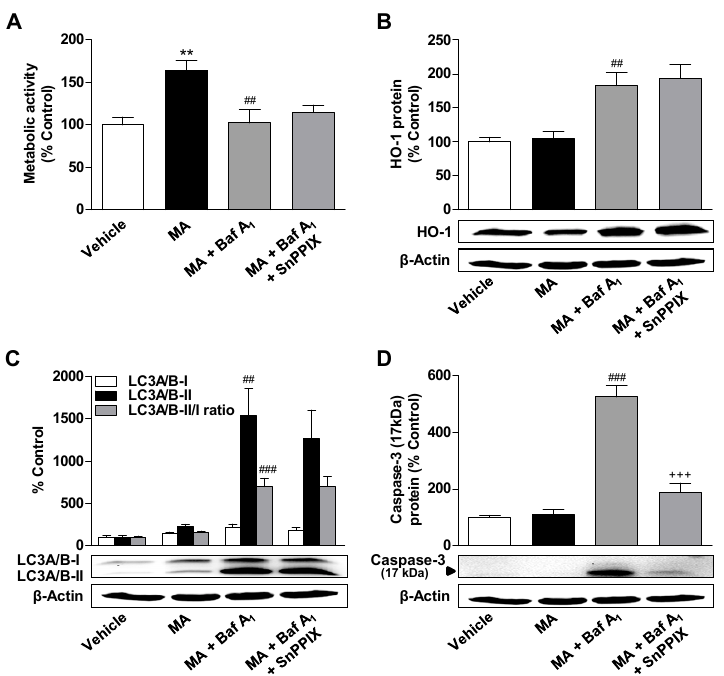
Figure 8. Effects of HO-1 inhibition on bafilomycin A 1 -induced changes in metabolic activity, HO-1 expression, autophagy, and apoptosis of MA-treated ADMSCs. ADMSCs were pretreated for 30 min with the autophagy inhibitor bafilomycin A 1 (Baf A 1 ; 100 nM) and the HO-1 inhibitor SnPPIX (25 µM), and after subsequent addition of MA (3 µM) or vehicle, the cells were co-incubated with the substances or vehicles for 24 h. Subsequently, the cells were analyzed for their metabolic activity ( A ), the expression of HO-1 ( B ) and LC3A/B-I/II ( C ), and the cleavage of caspase-3 ( D ). The protein expression values were normalized to β -actin. The same actin blot was used as control in B,C, and D , since the proteins analyzed in these Western blots were resolved on the same gel. The percentage control provides a comparison with the vehicle-treated group (set to 100%). The data represent mean values ± SEM of n = 6 ( A ) or n = 5 ( B – D ) different donors. ** p < 0.01 vs. vehicle control; ## p < 0.01, ### p < 0.001 vs. MA; +++ p < 0.001 vs. MA + Baf A 1 ; one-way ANOVA with Bonferroni’s post hoc test.